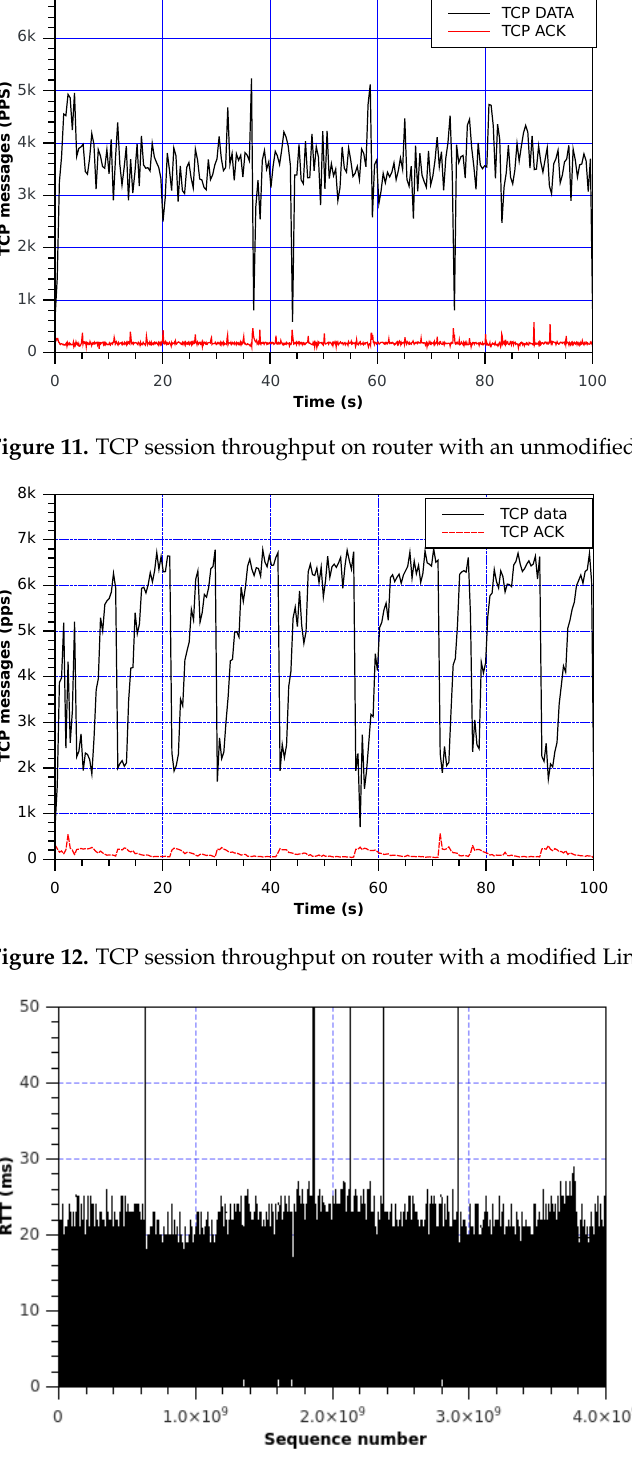
Figure 13. TCP session RTT on router with an unmodified Linux